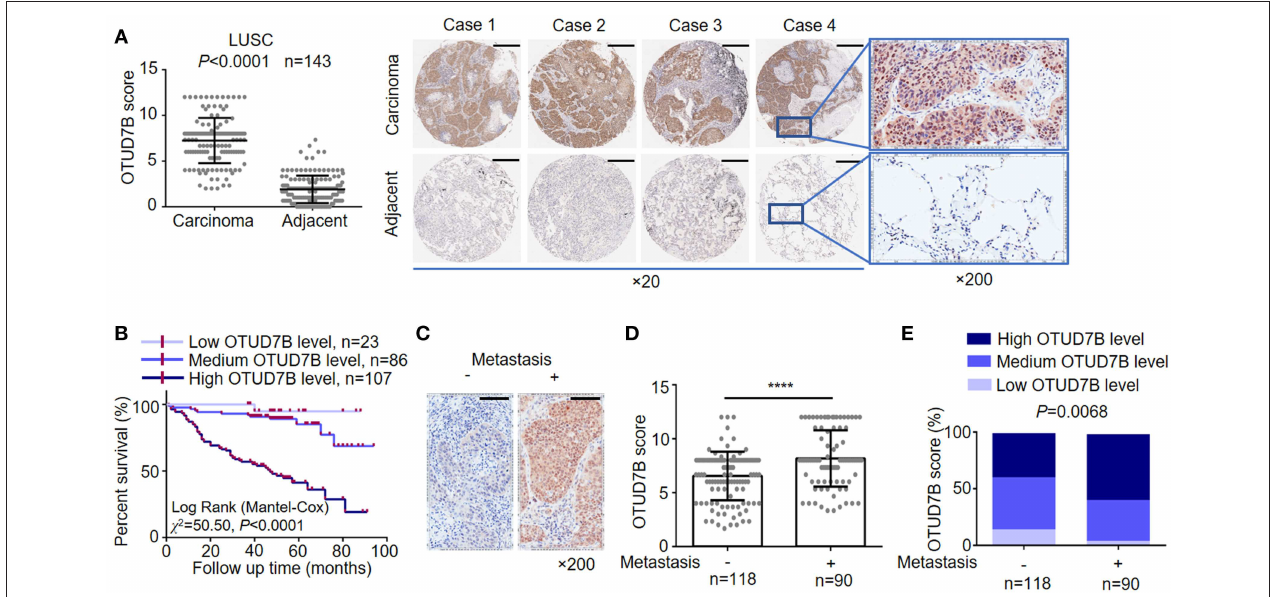
FIGURE 1 | OTUD7B is highly expressed in NSCLCs and correlated with a worse prognosis. (A) OTUD7B expression scores in LUSC and adjacent non-cancer tissues are shown as scatter dot plots. Small horizontal bars indicate the mean ± s.d. Each dot represents an individual sample. LUSC tissues were compared with matched adjacent non-cancer tissues using paired t -test. Right, Representative images of IHC staining of OTUD7B expression from 4 cases are shown. Magnification, × 20 (middle) and × 200 (right); scale bars, 400 µ m. (B) Kaplan-Meier survival curve of high, medium and low OTUD7B level NSCLC. Marks on graph lines represent censored samples. P -value refers to two-sided log-rank tests. (C) Representative images from IHC staining of OTUD7B expression in tumors with or without metastasis (lymph node metastasis and distant metastasis) are shown. Magnification, × 200; scale bars, 100 µ m. (D) Scatter dot plots of OTUD7B expression in the two groups of subjects described in (C) are shown. Data were analyzed using unpaired t -test and are shown as mean ± s.d. **** P < 0.0001. (E) The percentage of tumors in the two groups of subjects described in (C) . Data were analyzed using Pearson’s χ 2 test.